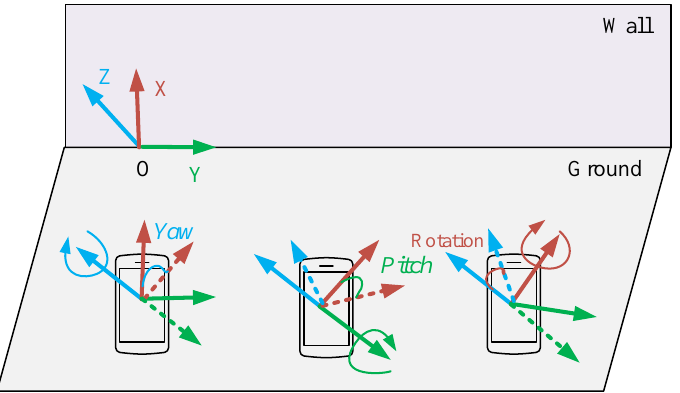
Figure 6. Three states of the smartphone.